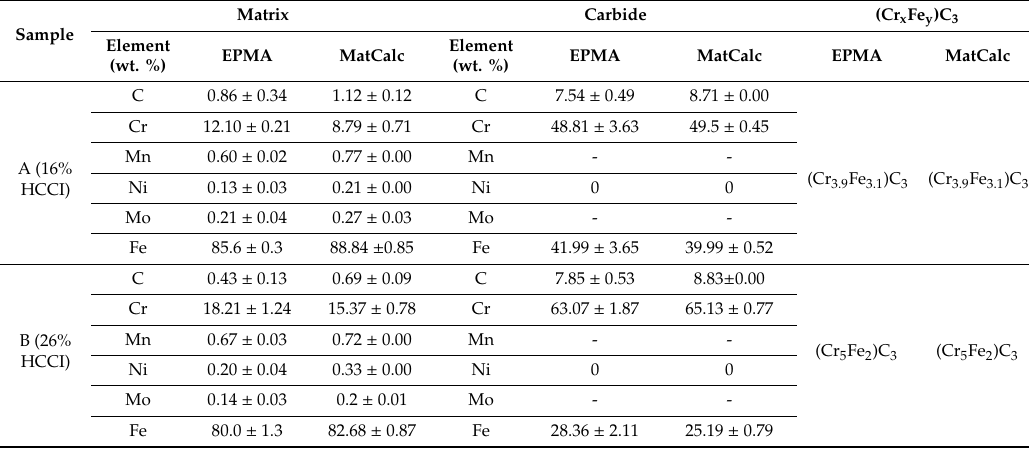
Table 5. Matrix and carbide elemental compositions (in wt. %) for the two alloys as determined by electron probe microanalysis (EPMA) and MatCalc. The distribution of Cr and Fe within the M 7 C 3 carbide is also